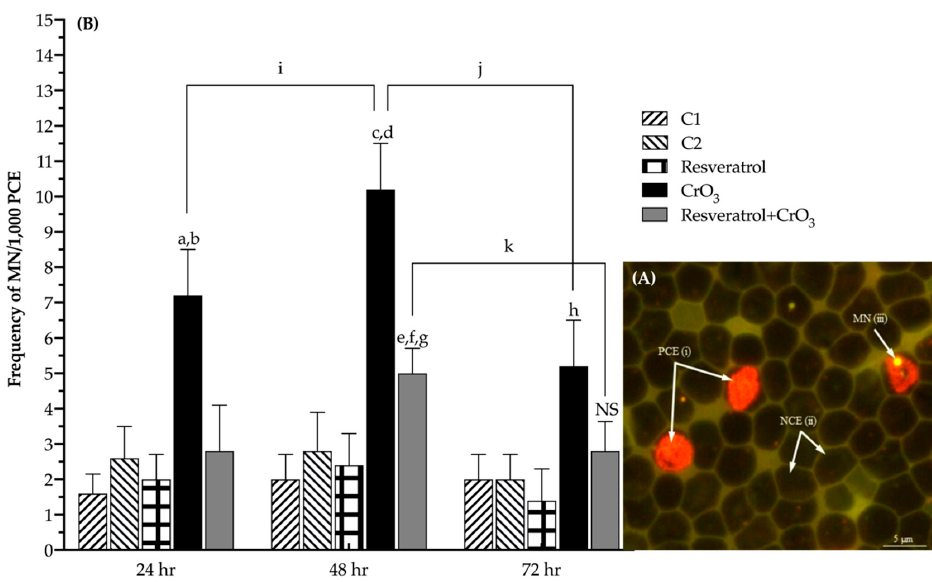
Figure 1. Effect of resveratrol and CrO 3 on the frequency of micronuclei (MN) were evaluated in the peripheral blood of mice. ( A ) Fluorescent microphotograph (1000 × ) of peripheral blood cells using the AO coating method. Polychromatic erythrocytes (PCE) stain fluorescent orange ( i ), normochromatic erythrocytes (NCE) do not stain at all (shadow) ( ii ), and MN fluoresces yellow ( iii ). ( B ) Data show the MN frequency at 24, 48, and 72 h minus the MN frequency at 0 h (net induction frequency: NIF, see results text). The frequencies of MN in the resveratrol + CrO 3 group decreased by 63, 50, and 47% at 24, 48, and 72 h, respectively, compared with those in the CrO 3 group. A total of 4000 PCE were evaluated in each mouse ( n = 5 mice/group). Statistical significance was determined using two-way repeated measures-ANOVA followed by Tukey’s post-hoc test. Analysis by treatments: a p < 0.001 vs. C1, 24 h; b p < 0.004 vs. resveratrol + CrO 3 , 24 h; c p < 0.0001